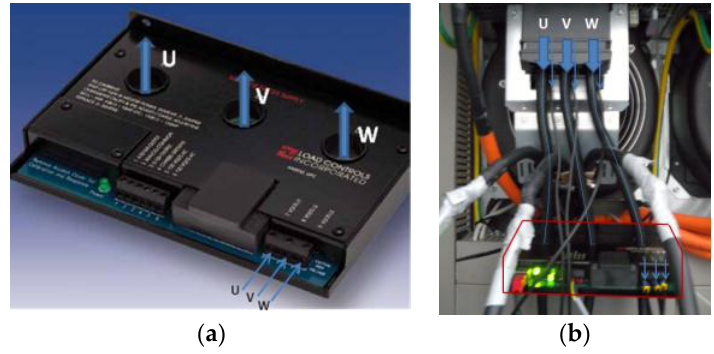
Figure 11. ( a ) Power sensor type UPC-E; ( b ) Sensor installation on the plate